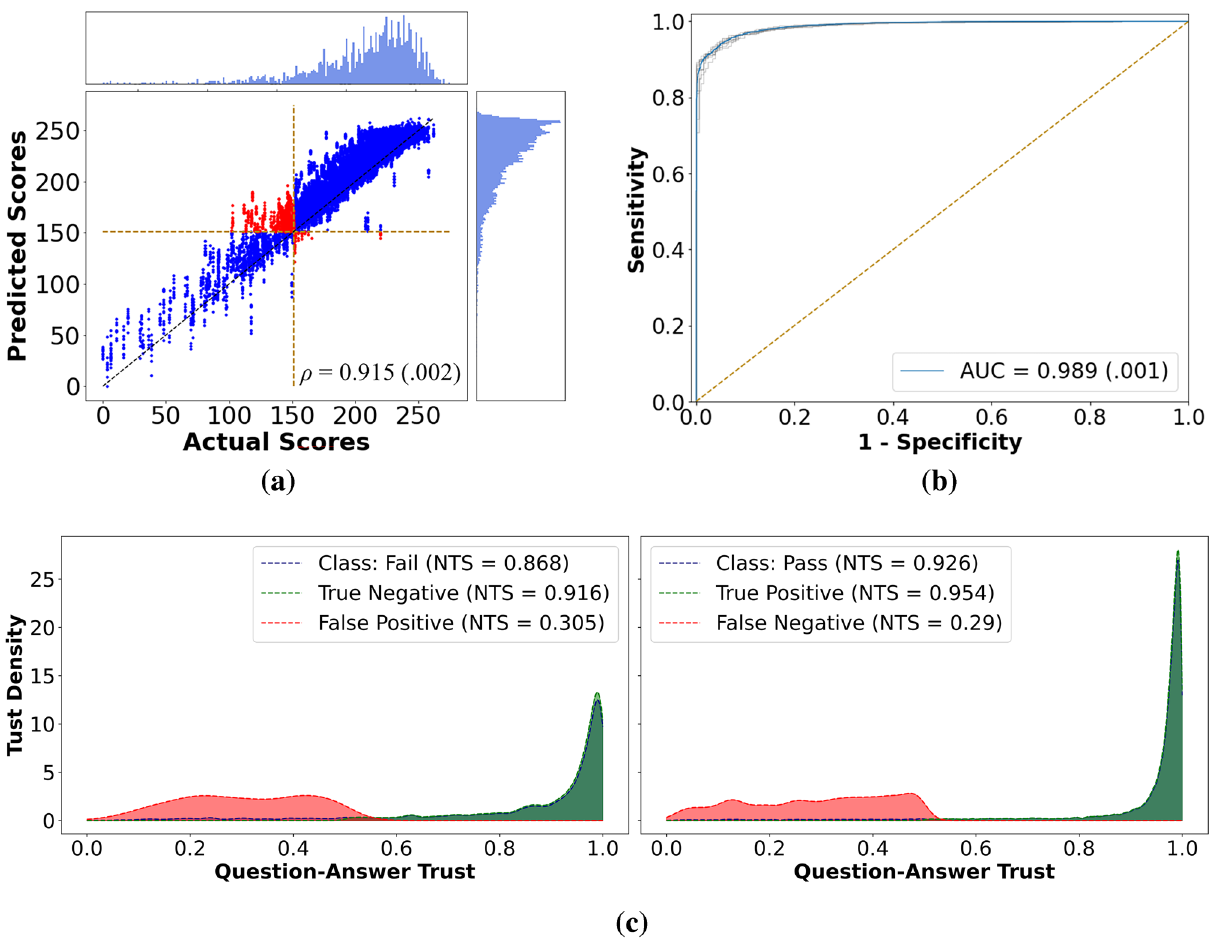
Figure 2. Results for the primary PC datasets. (a) Actual vs. predicted FLS scores for all ten training sessions combined. Here, the histograms show the frequency of samples for a given score. As seen, the network has a slightly inflated score prediction trend resulting in some trials close to the cut-off ratio to cross it—shown in red. Since classification analysis was conducted separately, this inflated prediction does not affect the pass/fail prediction accuracy. (b) The ROC curves. The blue line is the average of 10 running sessions, each shown in gray. The yellow line represents the random chances. (c) Question–answer trust plots for each class. The VBA- Net has high trustworthiness for true predictions. i.e., Softmax probabilities are close to 1.0 for the majority of the samples, as shown in green. On the other hand, the network is cautious about wrong predictions, i.e., the Softmax probabilities are close to the threshold of 0.5 and do not accumulate on the extreme end of 0.0— illustrated in